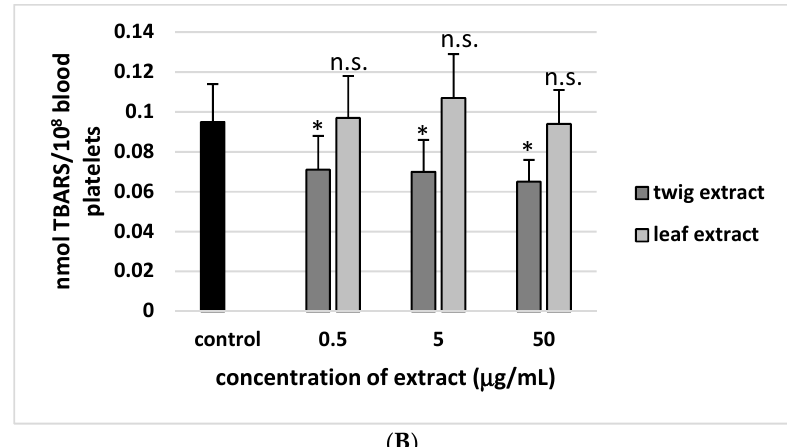
Figure 5. Twig and leaf extract (0.5, 5 and 50 µ g / mL; 30 min) on lipid peroxidation in resting platelets ( A ) and in blood platelets activated by thrombin ( B ). In these experiments, blood platelets not treated with plant extract were used as control samples (positive control). Data represent mean ± SE of 6 healthy volunteers (each experiment done in triplicate). The three di ff erent concentrations of the twig extract (0.5, 5 and 50 µ g / mL) had a statistically significant compared to controls (* p < 0.05). However, none of the three di ff erent concentrations of the leaf extract (0.5, 5 and 50 µ g / mL) had any statistically significant e ff ect compared to controls ( p > 0.05 (n.s.)). Only the twig extract was found to significantly reduce the process of O 2 − production in resting platelets and activated platelets (Figure 6A and B).